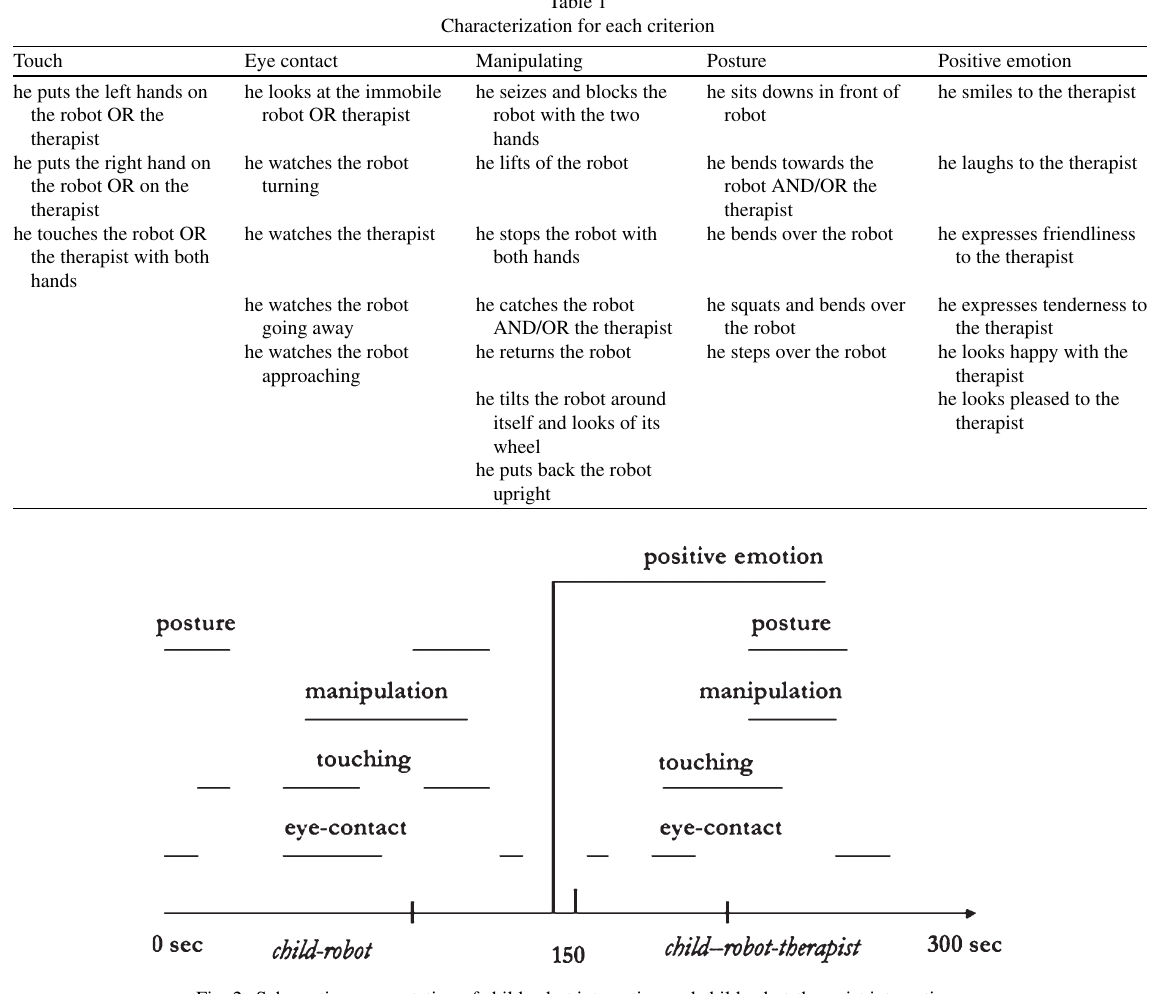
Fig. 2. Schematic representation of child-robot interaction and child-robot-therapist